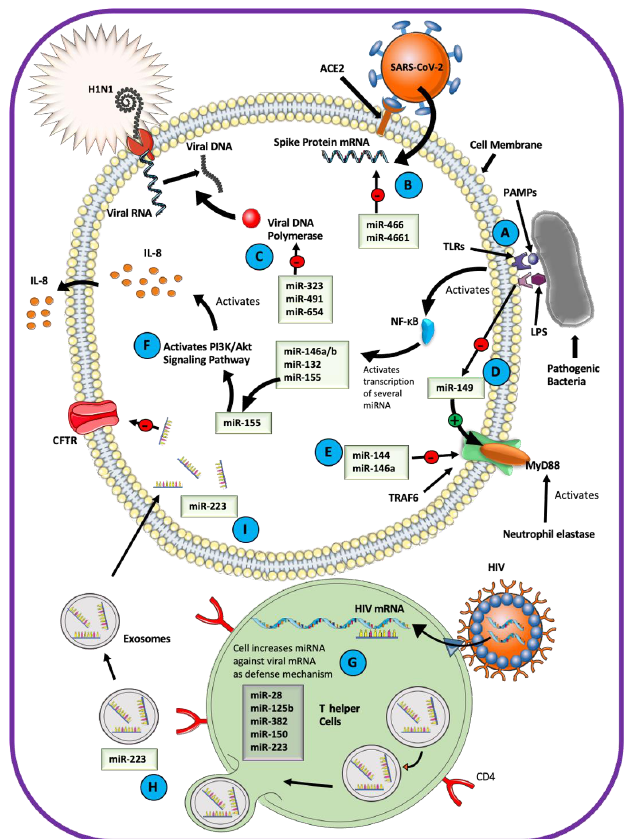
Figure 3. Role of miRNAs in the host–pathogen interaction. (A) Toll-like receptors (TLRs) engage with the pathogen-associated molecular patterns (PAMP) and activate the transcription factor nuclear factor-κB (NF-κB) in the host cell. (B) miRNA directly targets the mRNA of retroviruses in host cells. (C) miRNA participates in defense mechanisms and targets the genomic replication of viral DNA. (D) LPS inhibits miR-149, a direct inhibitor of MyD88, allowing activation of inflammation via the MyD88/IRAK/TRAF6 signaling pathway and expression of IL-8 in the CF airway. (E) Viral stimulated miR-144 and miR-146a target the TRAF6 signaling pathway to counteract the interferon defense responses in the human airway. (F) miRNA activated by NF-κB targets proteins that inhibit the PI3K/Akt signaling pathway to activate inflammation via IL-8. (G) Immune cells such as T helper cells can increase the expression of miRNAs against viral mRNA as defense mechanisms. (H) miRNA can also be transported from one cell to other cells through extracellular vesicles and could target ion channel proteins such as CFTR (I). ACE2: Angiotensin-converting enzyme-2; SARS-CoV-2: Severe acute respiratory syndrome coronavirus 2; PAMPs: Pathogen-associated molecular patterns; TLRs: Toll-like receptors; LPS: Lipopolysaccharide; NF-κB: nuclear factor-κB; MyD88: Myeloid differentiation primary response 88; IRAK: interleukin-1 receptor-associated kinase; TRAF6: tumor necrosis factor receptor-associated factor 6; H1N1: A subtype of Influenza A virus; HIV: Human immunodeficiency virus; miR / miRNA: micro RNA; mRNA: messenger RNA; IL-8: Interleukin-8; CFTR: Cystic fibrosis transmembrane conductance regulator; CD4: Cluster of di ff erentiation 4; PI3K: Phosphoinositide 3-kinases; Akt: Protein kinase B (a serine / threonine-specific protein